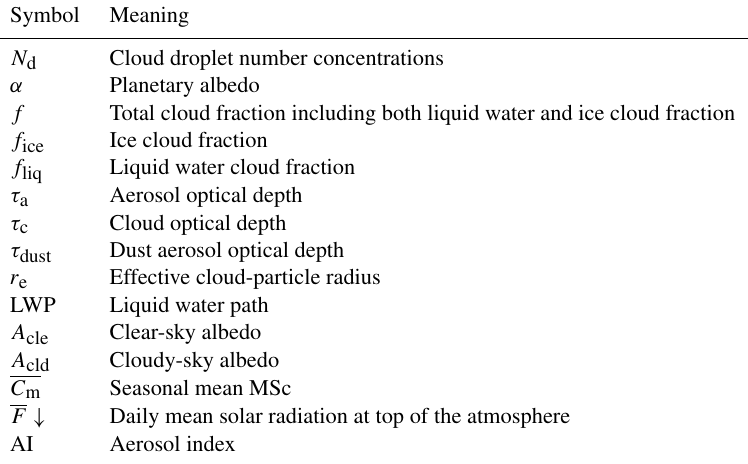
Table A1. A summary of notation used for equations in this